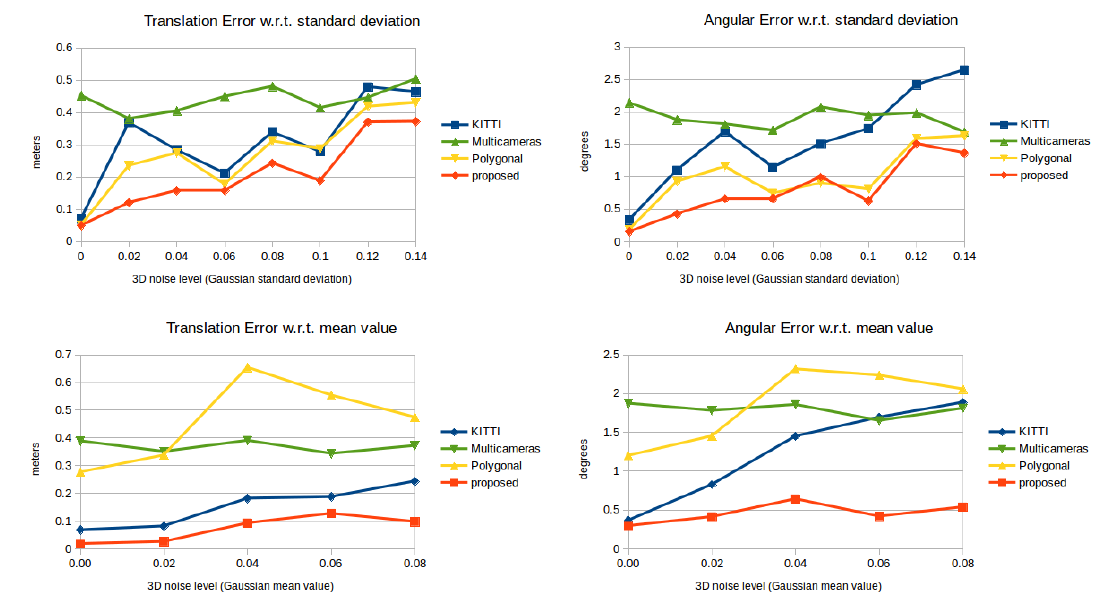
Figure 5. The translation ( left ) and rotation ( right ) errors in the synthetic tests. Top row: the 3D noise level is measured by varying Gaussian standard deviation with zero mean value. Bottom row: varying mean value and a 0.02 standard